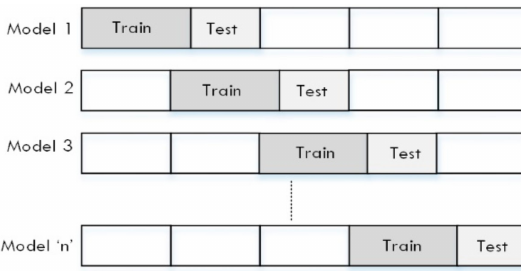
Figure 13. Train test split for model